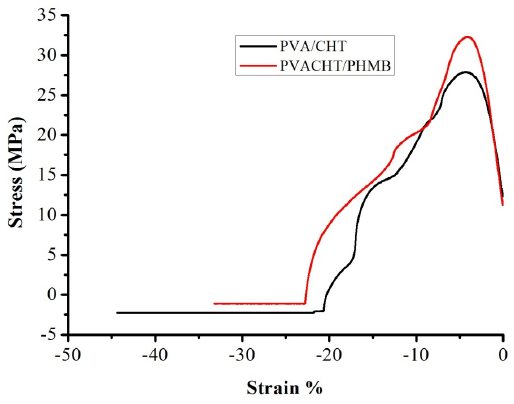
Figure 5. Strain versus strength of PVA/CHT/PHMB blends formed film.